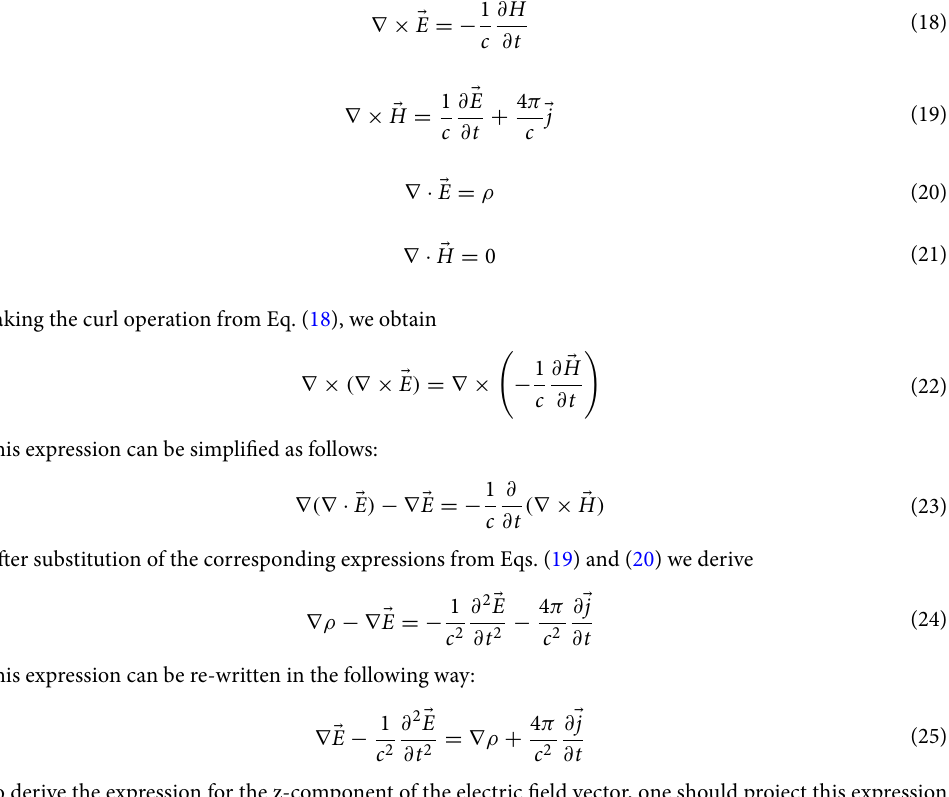
Figure 11a–e represents E field distribution for five absorption peaks at 3.80, 5.65, 8.45, 10.82, and 15.92 GHz, respectively. At 3.80 GHz E field is localized at the left corner of the outer square ring and lower right corner of two square rings. Whereas, at 5.65 GHz, the electric field is observed at the lower-left corner and upper right corner. The right section of the square ring and the split gap of the inner ring represent a powerful electric field. At 8.45 GHz, the medium E-field is noticed at the left low down and upper portion of the two outside square rings and each gap of the split. A major difference of electric field allocation is viewed at 10.82 GHz, wherever a more spreading high E field is noticed near the middle star part of the structure and the left upper part. At 15.92 GHz, a significant electric field is observed in the middle star and left top corner of the square rings. The electric field distribution pattern reveals that as the electric field strength increases with frequency, so does the absorption. This effective induced electric field reverts to the electric field incident, which in turn energizes the electric field